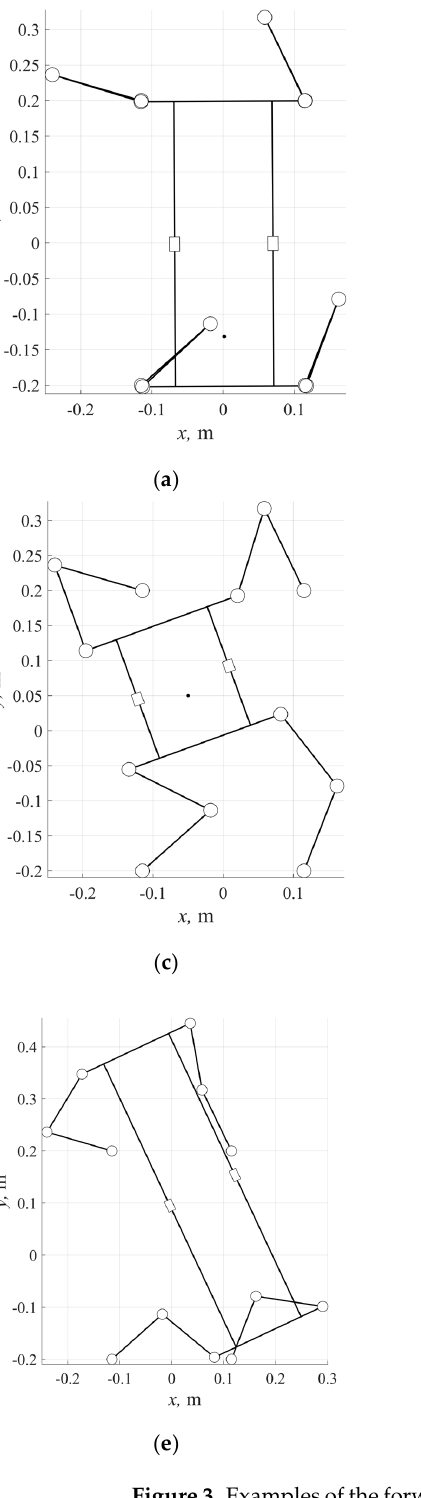
Figure 3. Examples of the forward kinematics solution contained in Table 1: ( a ) Solution 1; ( b ) Solution 2; ( c ) Solution 3; ( d ) Solution 4; ( e ) Solution 5; ( f ) Solution 6.